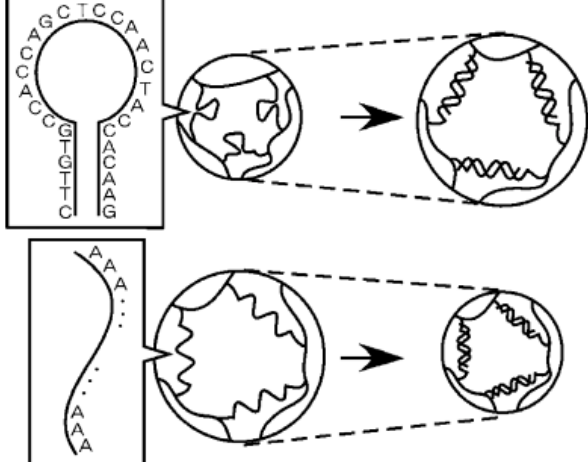
Figure 2. The response of novel hybrid hydrogels containing ssDNA as a cross-linker to ssDNA. Reprinted from [36] with permission from the American Chemical Society (2005).